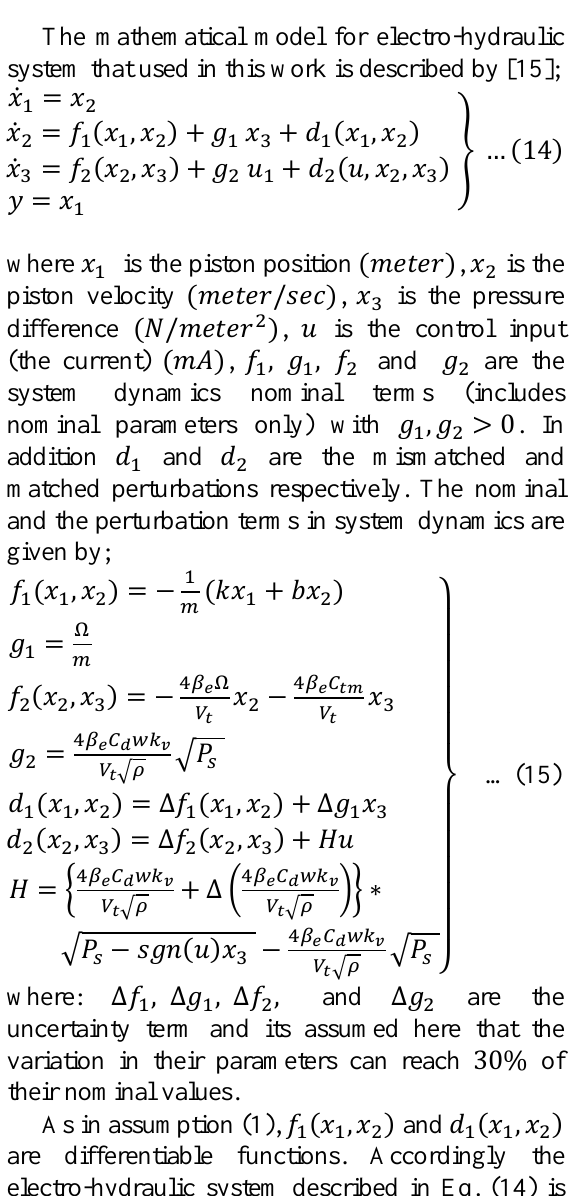
The system parameters [8] . The Description The parameter